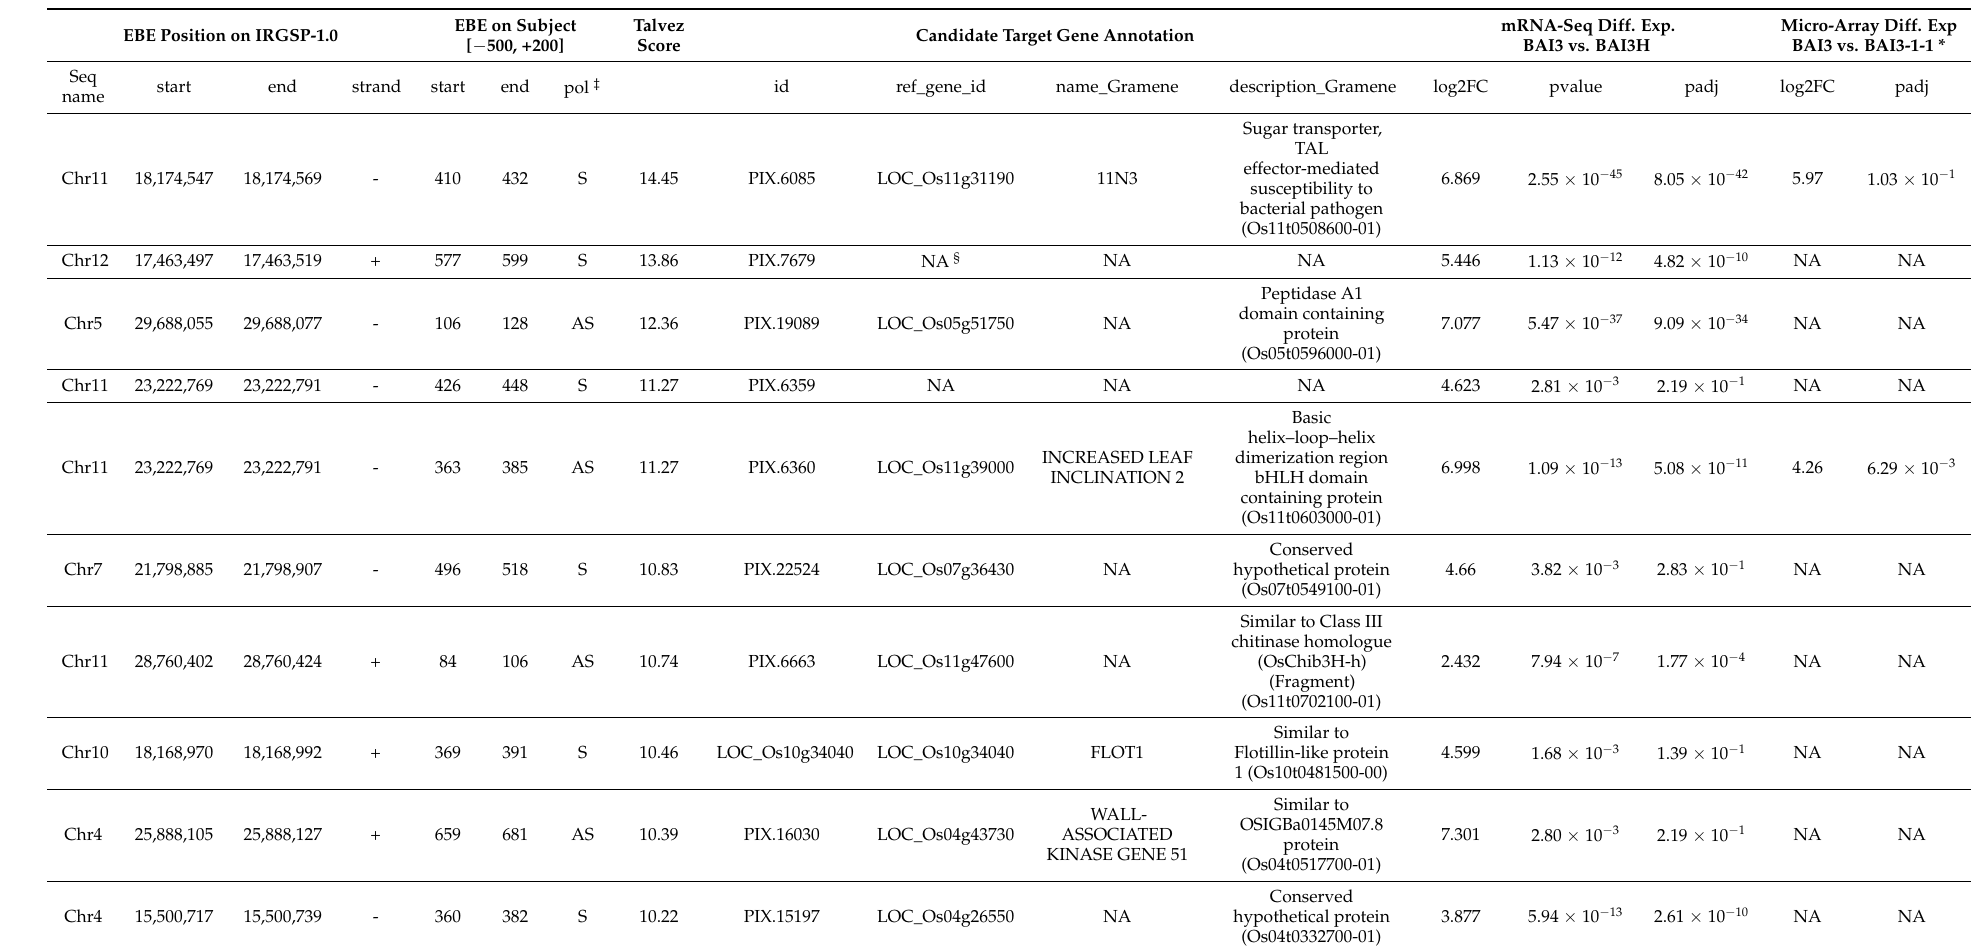
Table 1. Candidate TalC targets in the Nipponbare